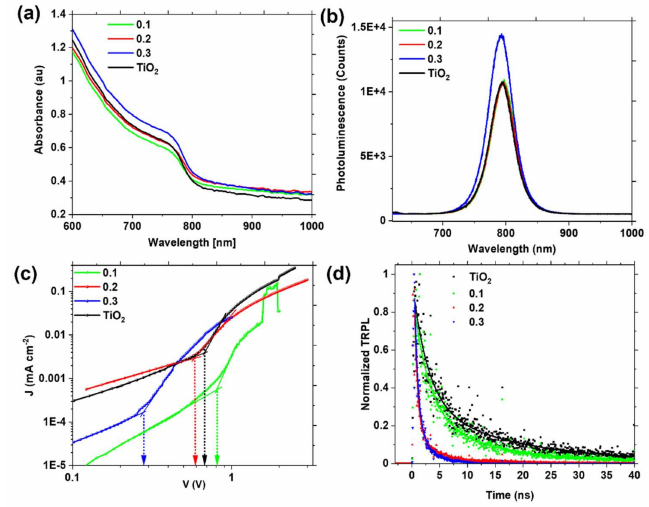
Figure 6. Optical properties of perovskite films for different volume proportion of SnO 2 : ( a ) UV-Vis absorbance spectra ( b ) PL spectra, ( c ) J-V curves of electron only devices and ( d ) TRPL spectra of perovskite films on different